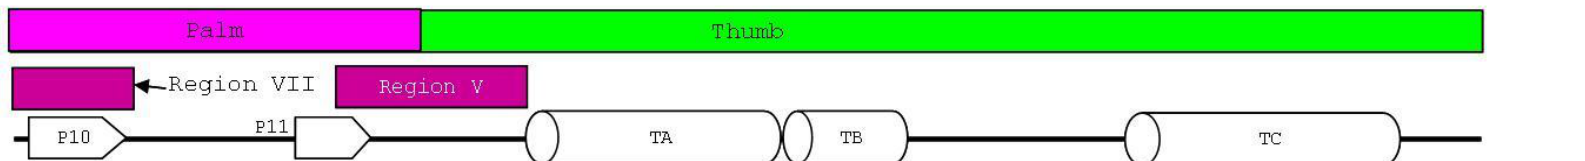
Appendix Figure A1.